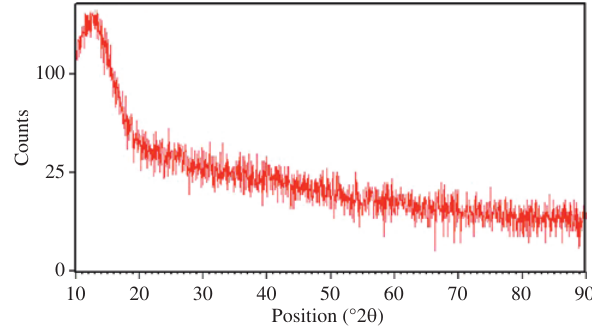
Figure 3: Fourier transform infrared (FTIR) spectra of green syn- thesized iron nanoparticles (INPs); peaks at 1070 cm − 1 , 1636 cm − 1 , 2800 cm − 1 , and 3467 cm − 1 were due to C–O, C = O, C–H, and OH bonds, respectively.